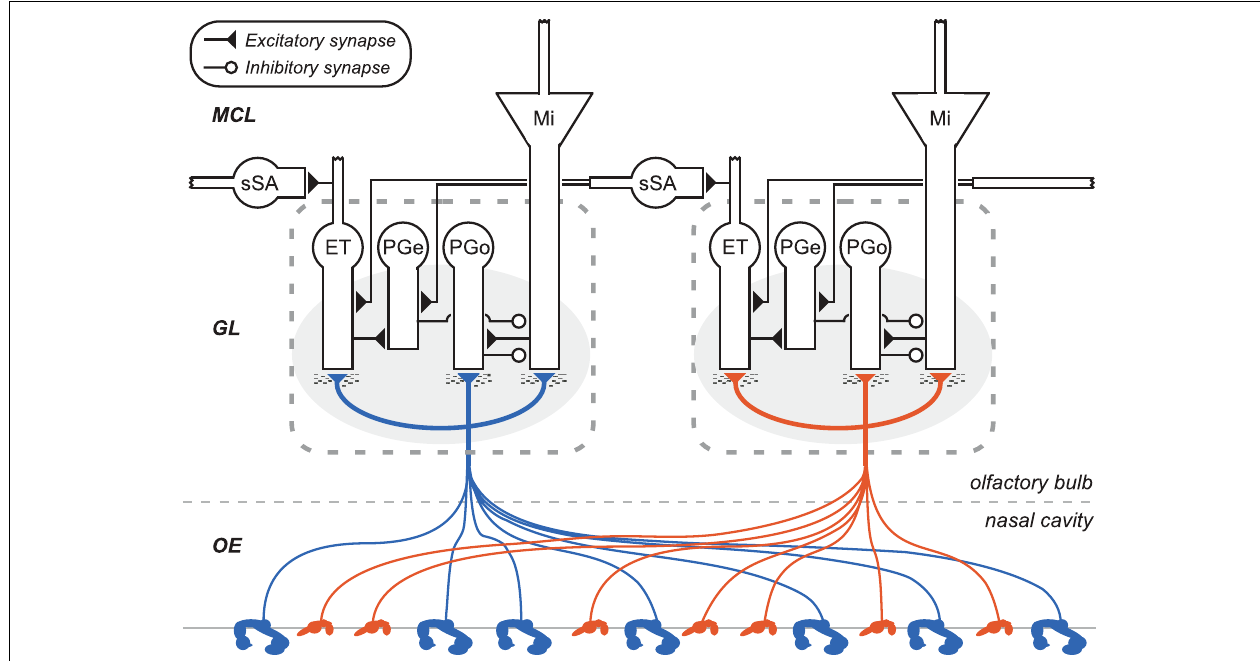
together with mitral cells; not shown). Glomerular interneurons include olfactory nerve-driven periglomerular cells (PGo), external tufted (ET) cell-driven periglomerular cells (PGe), and multiple subtypes of ET cells; both types of PG cells inhibit mitral cells. Superficial short-axon cells (sSA) are not associated with specific glomeruli but project broadly and laterally within the deep glomerular layer, interacting with glomerular interneurons. GL, glomerular layer; MCL, mitral cell layer. Deeper layers of olfactory bulb (Cleland, 2010) are not